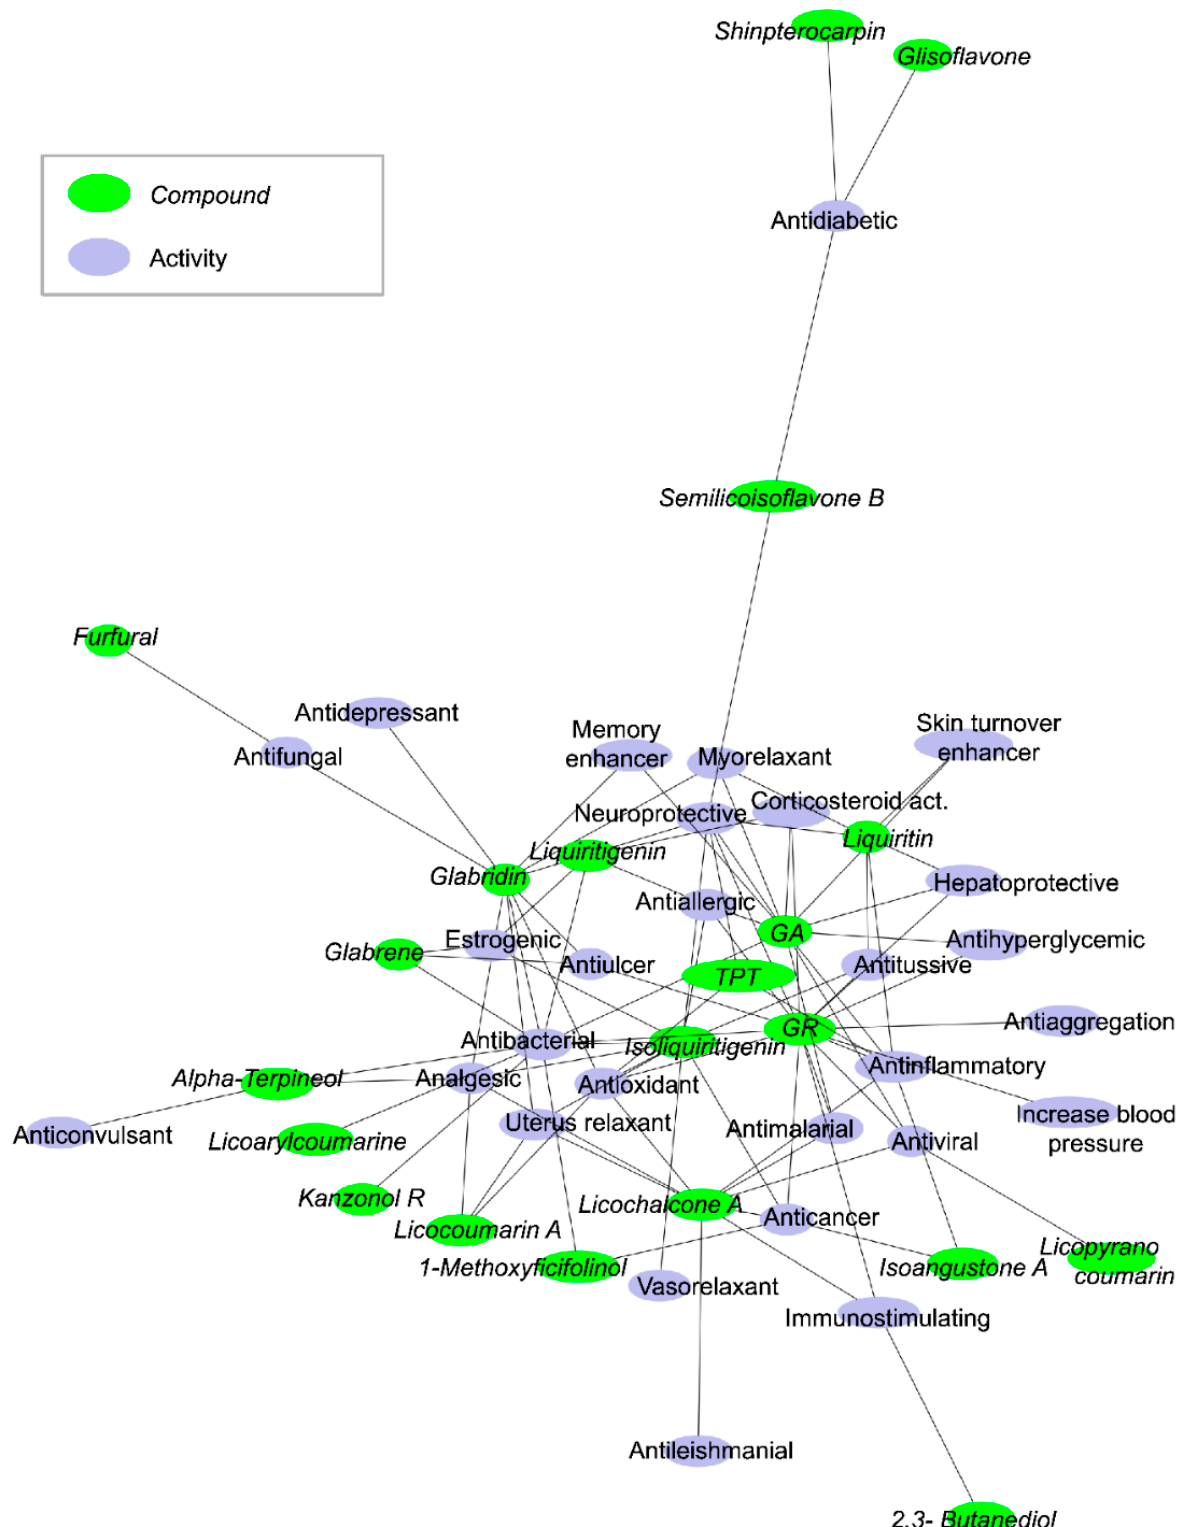
Figure 1. Network of potentially active compounds and their activities in licorice root extracts. The figure illustrates the active compounds (green circles) linked to their pharmacological activities (blue circles). The network is drawn using PyGraphViz and the “fdp” layout. In this representation, the most connected nodes are close together in the center of the network. GA and GR are the compounds with the most activities, and other compounds are on the sides of the network. GA and GR share many activities with other compounds. TPT is tetramethyl